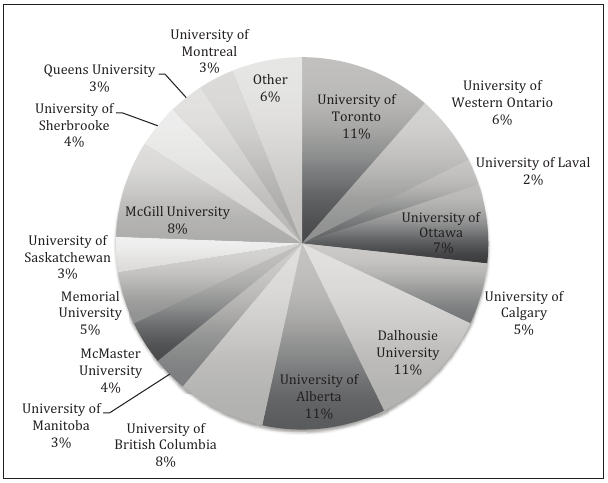
Figure 2) Distribution of participants according to the medical school grant-